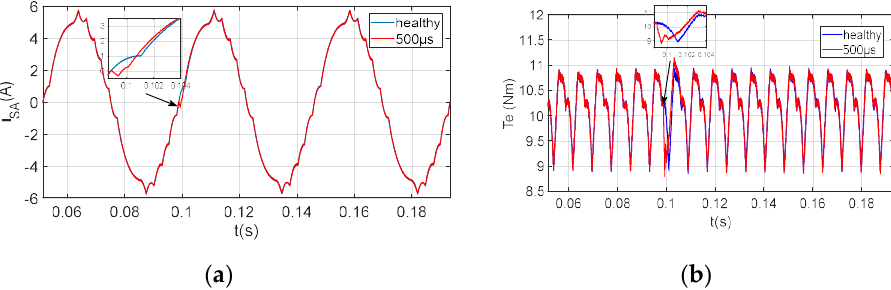
Figure 4. Intermittent 500 µs Open-Switch fault impact: ( a ) Phase current waveforms in healthy and faulty cases. ( b ) Electromagnetic torque in healthy and faulty cases.